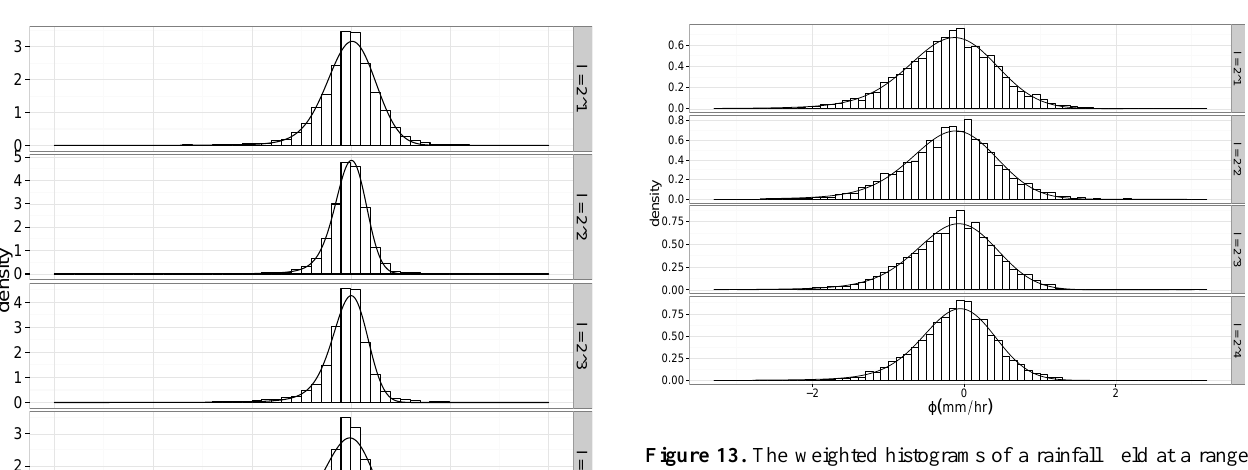
Figure 13. The weighted histograms of a rainfall field at a range Fig. 13. The weighted histograms of a rainfall field at a range of scales. The lines are the fitted distribu- of scales. The lines are the fitted distributions without any preset tions without any preset parameters. Note that the observed tail is a result of the local normalization, not parameters. Note that the observed tail is a result of the local nor- a natural feature of the rainfall field. malization, not a natural feature of the rainfall Figure 12. The weighted histograms of rainfall field increments at Fig. 12. The weighted histograms of a rainfall field increments at a range of scales. The lines are the a range of scales. The lines are the fitted distributions without any fitted distributions without any preset parameters. preset parameters. 34